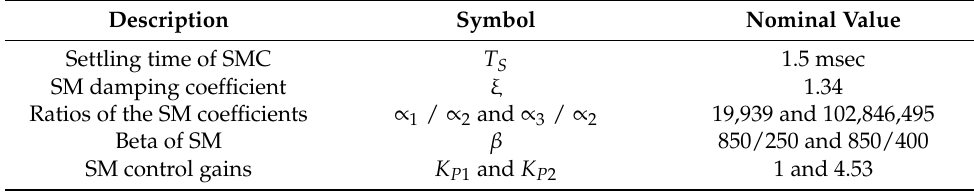
Table 1. The adopted SMC parameters.